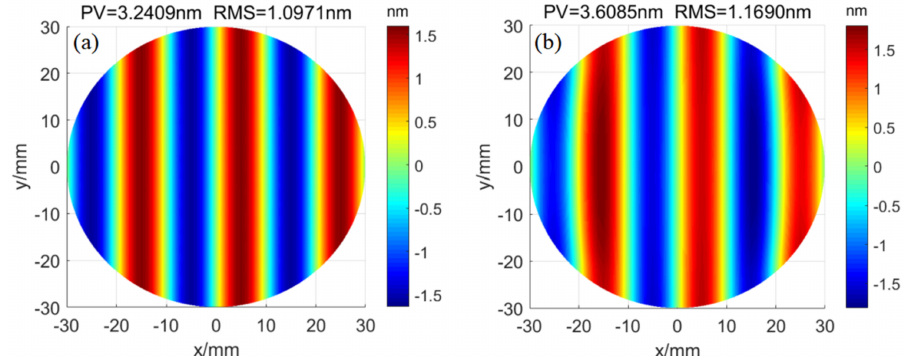
Figure 13. Simulated residual figuring error ignoring ( a ) and considering ( b ) the additional angle and target distance errors.